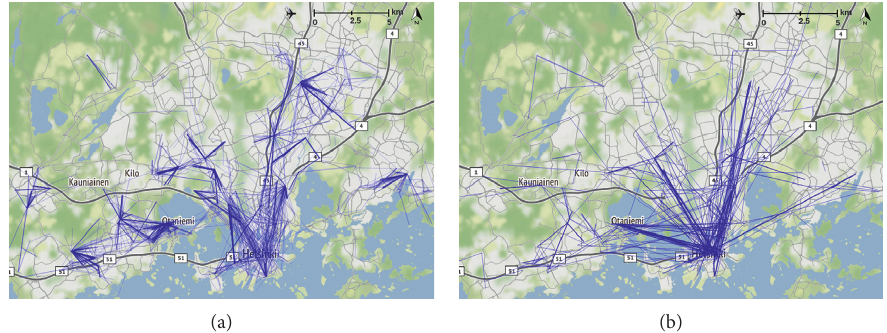
Figure 11: Desire lines of ODs of car trips with potential low-carbon time-relevant alternatives, when the alternative is (a) bike and (b) PT (map tiles by Stamen Design, under CC BY 3.0; data by © OpenStreetMap, under CC BY SA).